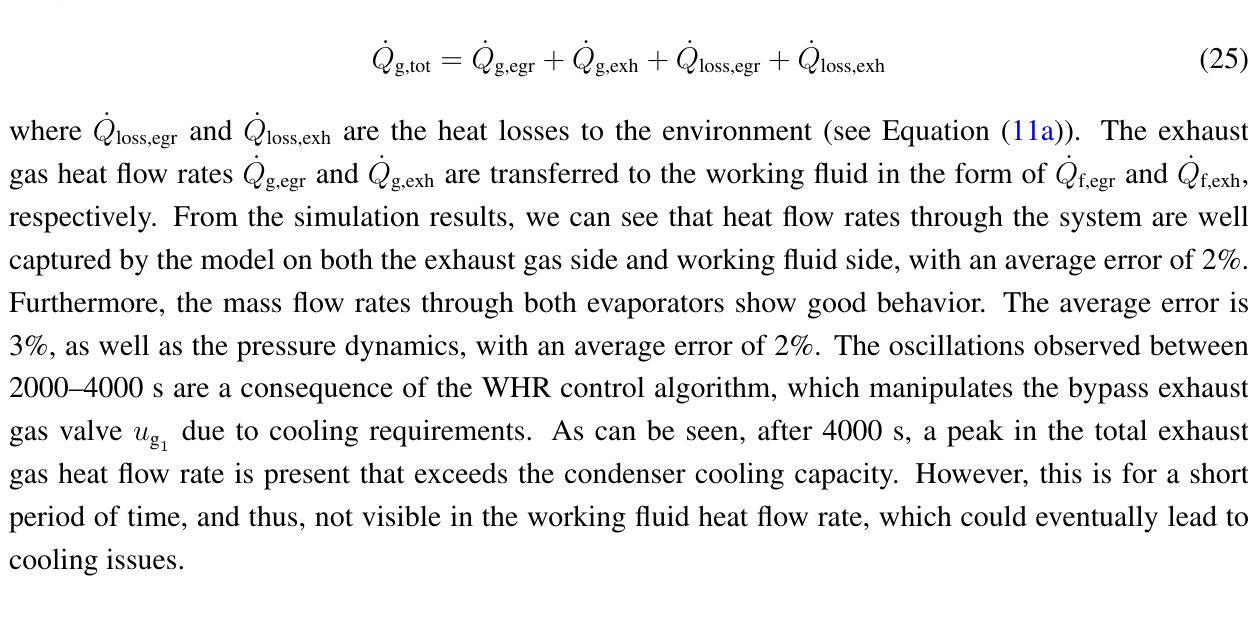
Figure 3. ( a ) Total exhaust gas heat flow rate, including losses and working fluid heat flow rate for both evaporators; ( b ) Working fluid mass flow rate through the evaporators and system